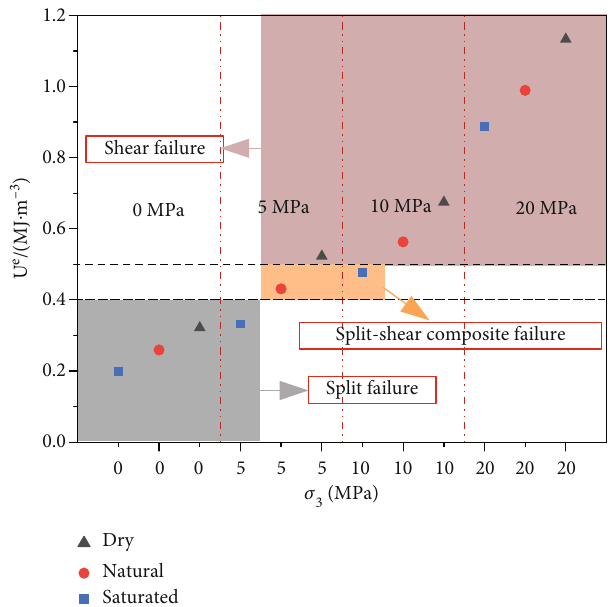
Figure 15: Relationship between rock failure modes and energy storage